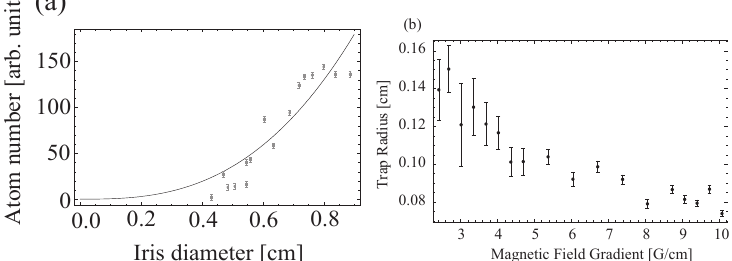
Figure 24. ( a ) Atom number as a function of iris diameter, d . The data shows a sensitive dependence on the beam size. For a well aligned trap and a well centered iris, the atom number can be expected exhibit a power law dependence shown by the solid line. For this experiment, the trap detuning was set to 15 MHz below resonance, the trap laser power was ∼ 65 mW, the repump laser power was set at ∼ 15 mW, and the magnetic field gradient was ∼ 7 G/cm. ( b ) Cloud radius (1/e) as a function of magnetic field gradient along the vertical direction. For this data, the trap laser power was fixed at ∼ 75 mW and the trap laser detuning was ∼ 15 MHz below resonance with a beam diameter of ∼ 1.0 cm. The repump power was ∼ 12